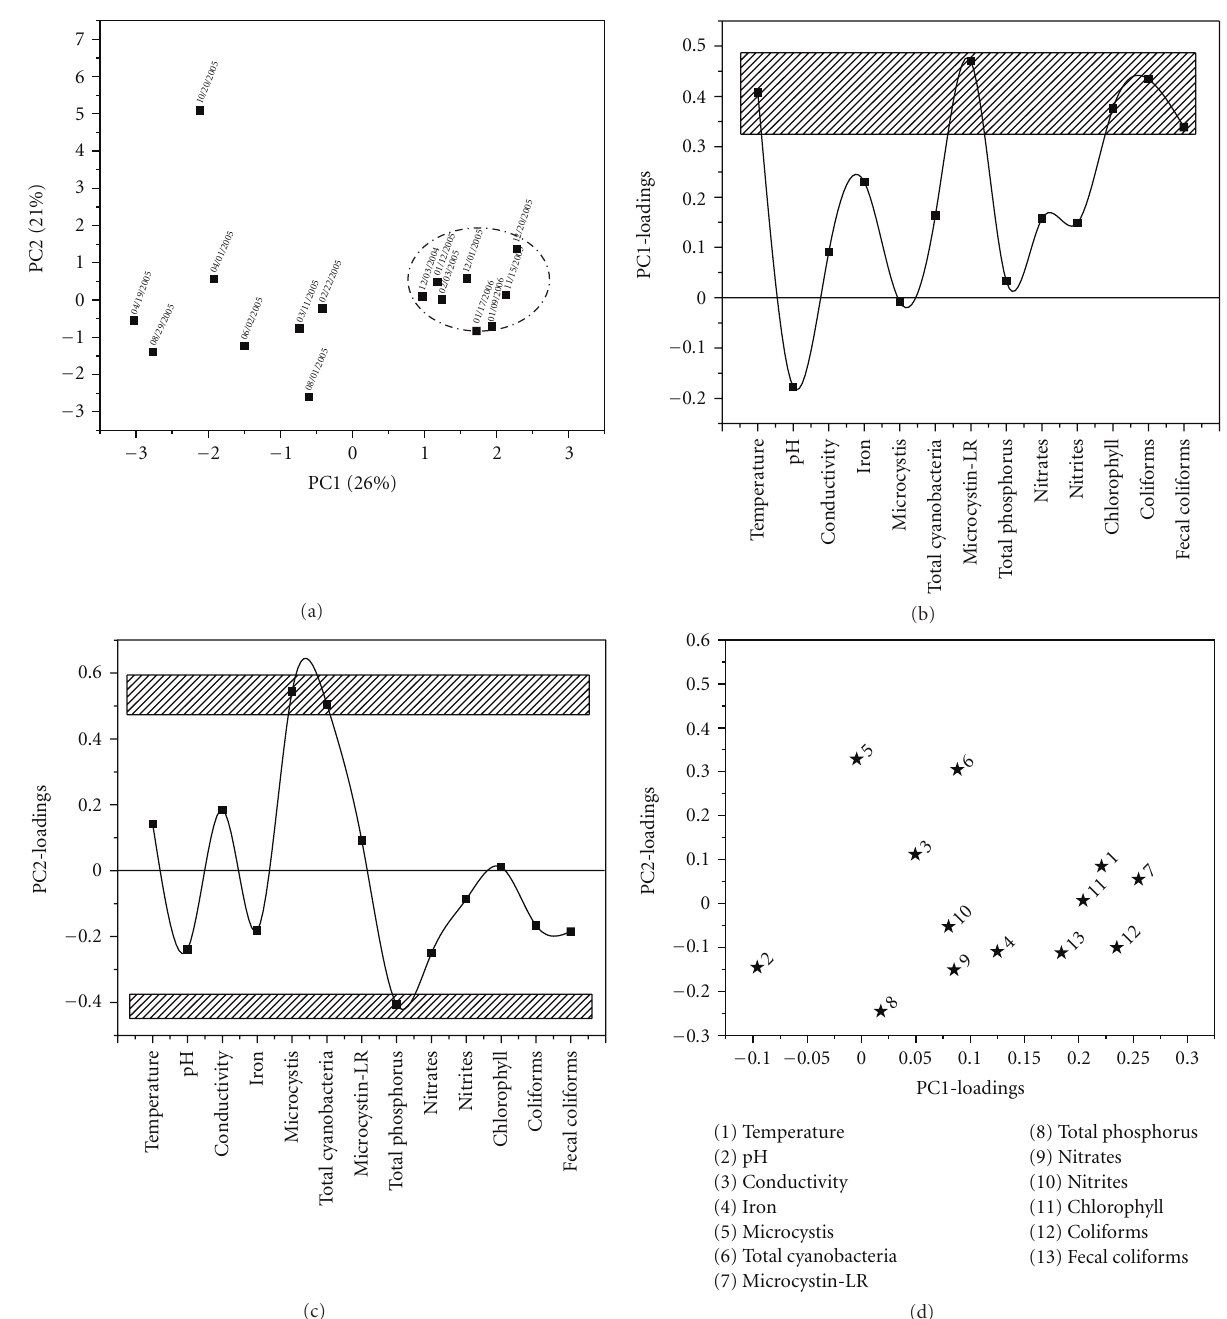
Figure 4: PCA results obtained for samples recollected from sampling point 3. (a) Two-dimensional PCA-scores plot for PC2 versus PC1, (b) and (c) correspond to one-dimensional loadings plots of PC1 and PC2, respectively, and (d) two-dimensional loadings plot.